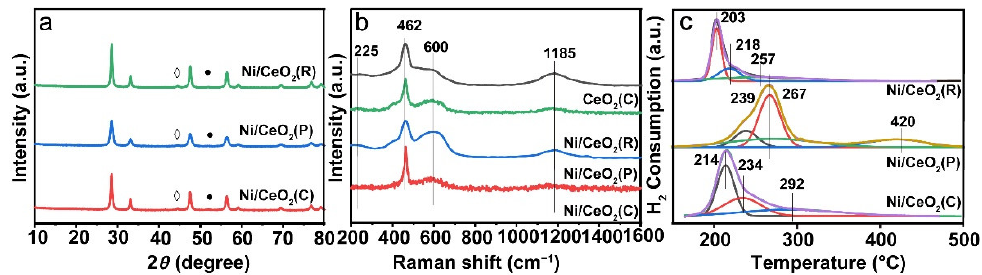
Figure 2. ( a ) XRD patterns (the rhombus and the circle represent the (111) and (200) crystal planes of Ni, respectively). ( b ) Raman spectra and ( c ) H 2 -TPR spectra of Ni/CeO 2 (R), Ni/CeO 2 (P), and Ni/CeO 2 (C) catalysts.